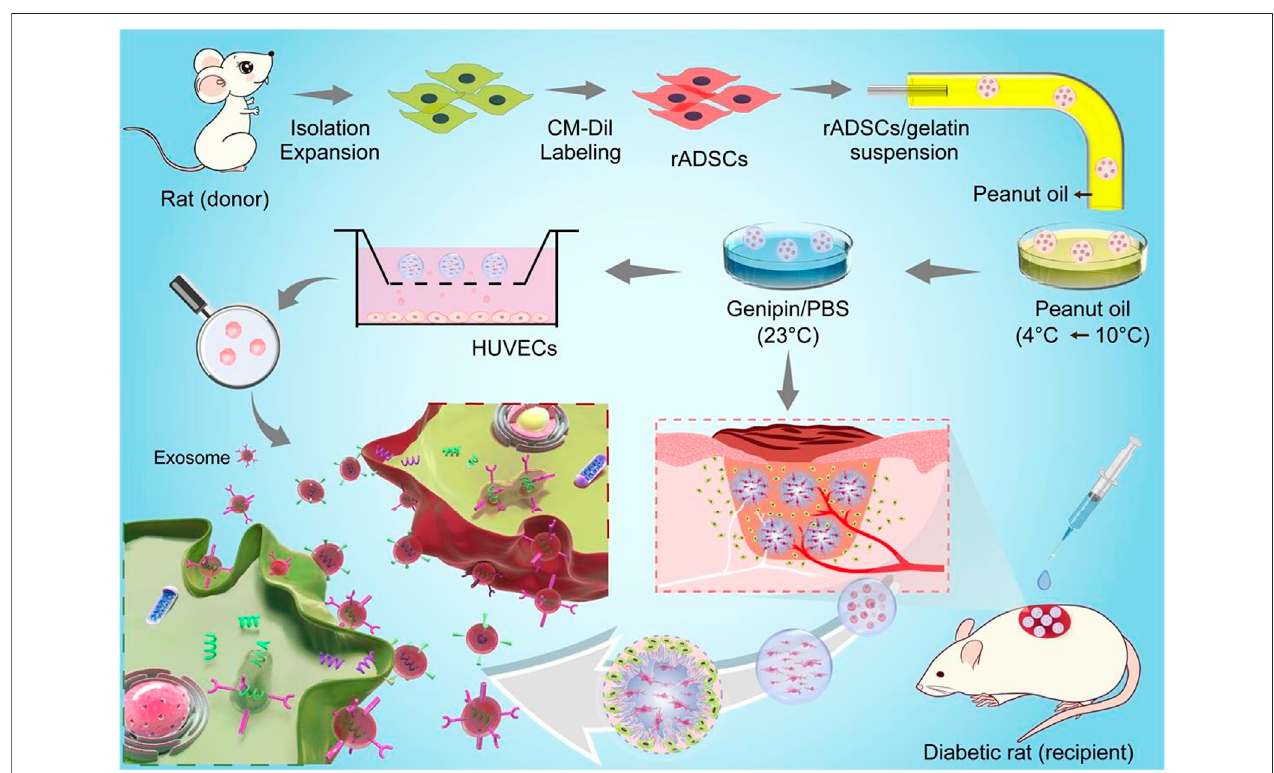
FIGURE8| SchemesforpreparationofCM-Dil-labeledrADSCs-ladengelatinmicrospheresandapplicationfordiabeticwoundhealing.rADSCswereisolatedand labeled with CM-Dil after expansion and then encapsulated in gelatin microspheres using a micro fl uidic method. After cross-linking, microspheres were applied in a full- thickness diabetic wound to enhance wound healing, including reepithelialization, angiogenesis (red tube), and nerve regeneration (white tube).Gelatin matrix degraded alongwith tissue regeneration in wound bed, and entrapped rADSCs in fl uenced surrounding cells via paracrine effect. Schematic diagram for paracrine effect was shown on left corner; exosomes were released from CM-Dil-labeled rADSC (red) and uptaken by recipient cell.